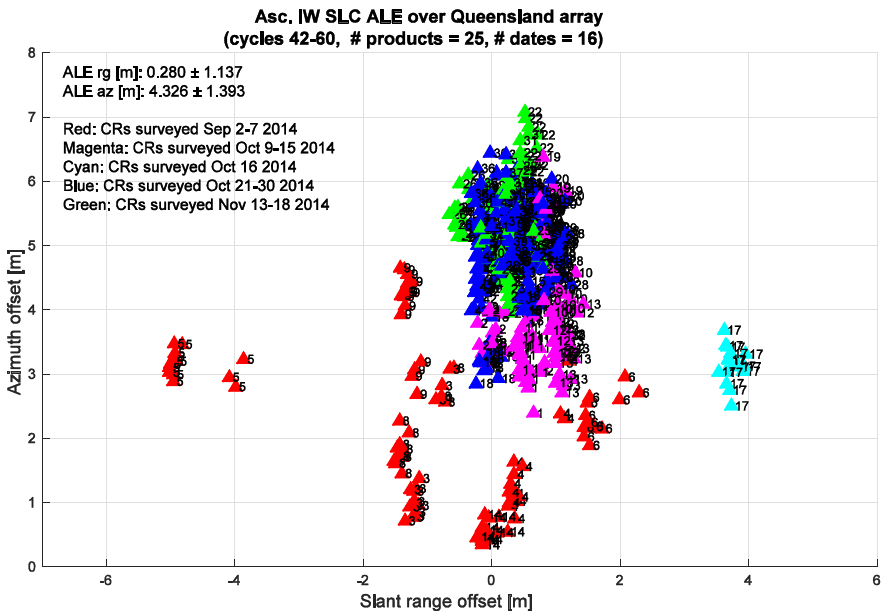
Figure 6. S-1 IW mode SLC product geolocation accuracy based on 25 products acquired over Australian Surat corner reflector (CR) array from March–October 2015, before correction of the original GPS survey download errors. Colour-coding indicates survey period; the symbol numbers indicate specific reflector IDs.